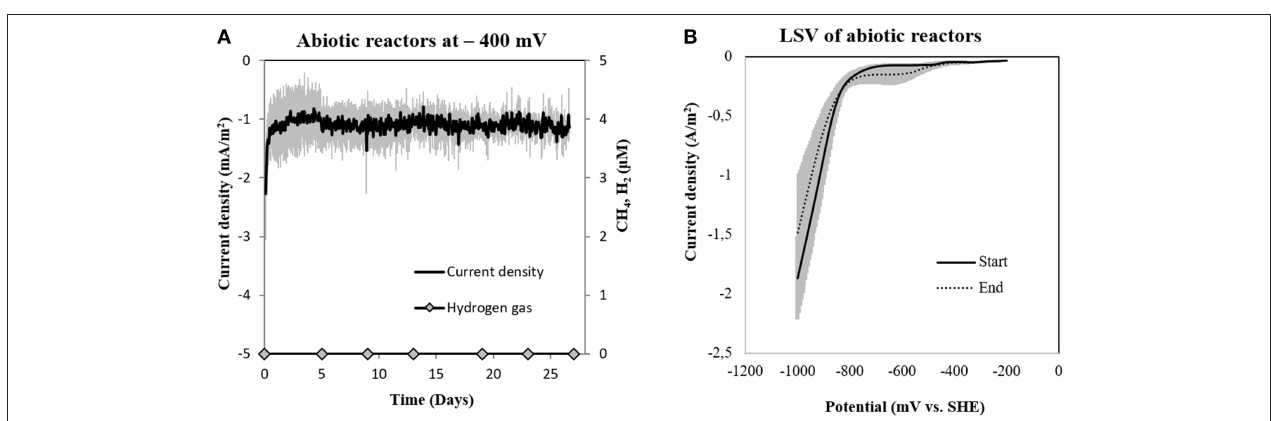
FIGURE 4 | (A) Current consumption and gas production in four abiotic reactors at − 400mV (vs. SHE) and (B) Linear Sweep Voltammetry (LSV) of abiotic reactors at the start and end of the experiment ( n = 3).